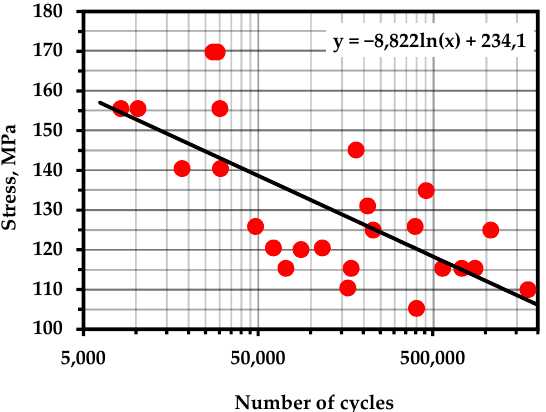
Figure A17. S–N Curve—Steel M250 (Temperature—293 К ; frequency—60 Hz) [108].